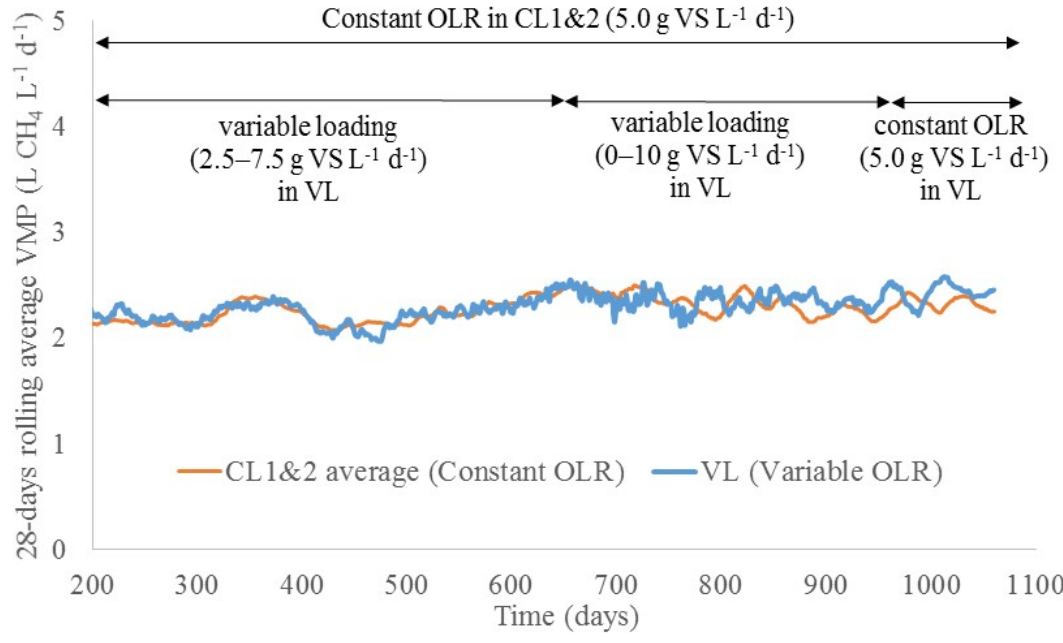
Figure 4. 28-day rolling average volumetric methane production of digester VL and control digesters CL1&2. (Note: from day 777 on, the digesters were no longer supplemented with the full set of 11 TEs, but with Co and Se only).